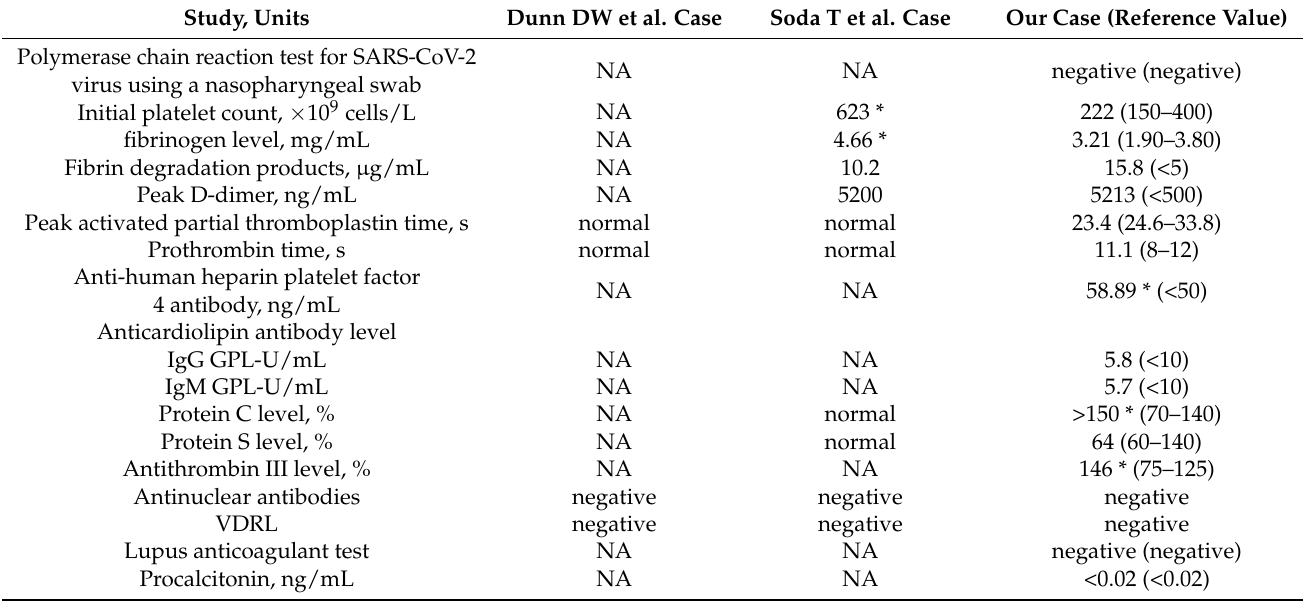
Table 1. Results from the selected laboratory data in our case and review of the literature. Study, Units Dunn DW et al. Case Soda T et al. Case Our Case (Reference